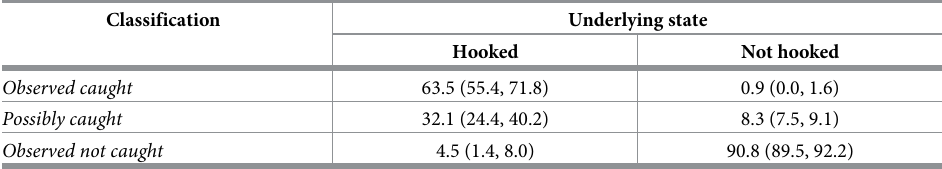
Table 2. Estimated posterior mean and 95% credible interval of the classification probabilities (in %) of seabird interactions with